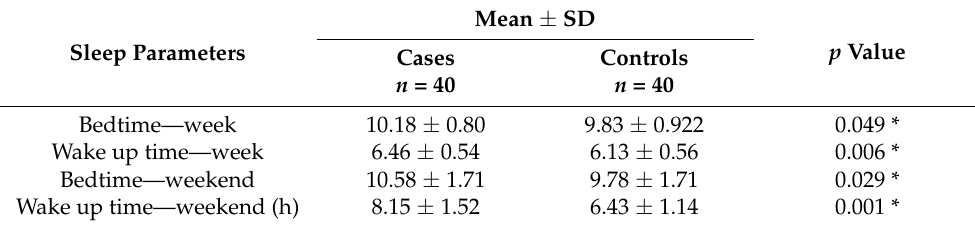
Table 9. Week versus weekend sleep schedule between ADHD and control